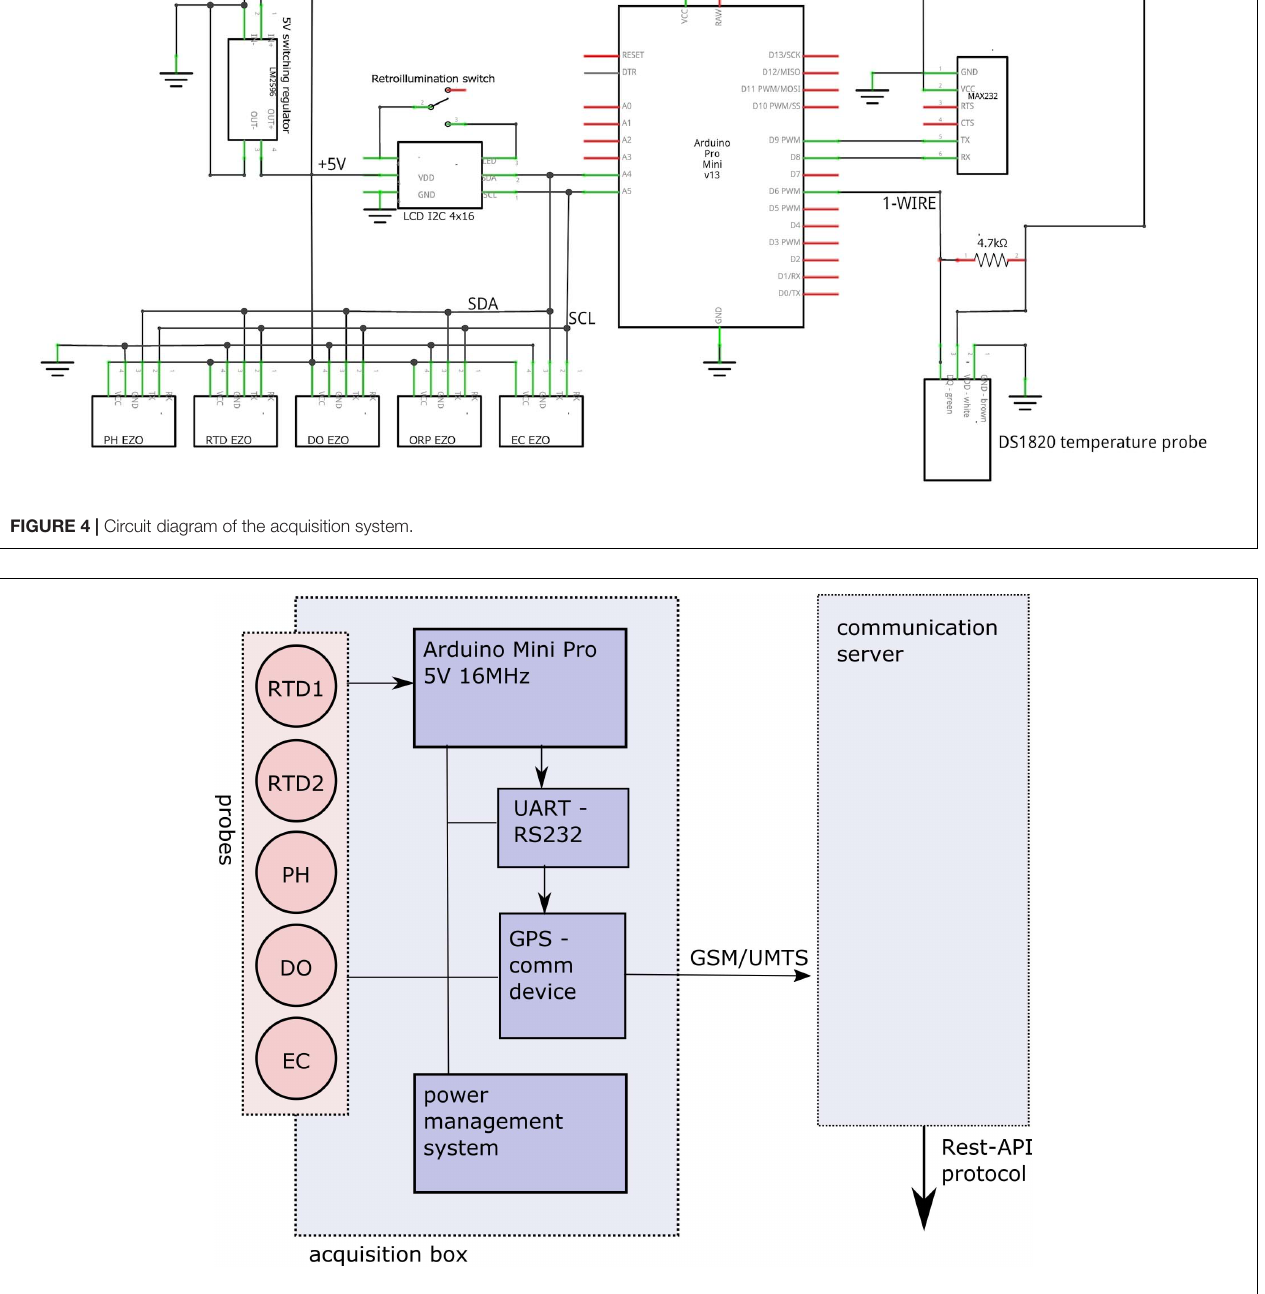
FIGURE 5 | Dataflow of the acquisition process.